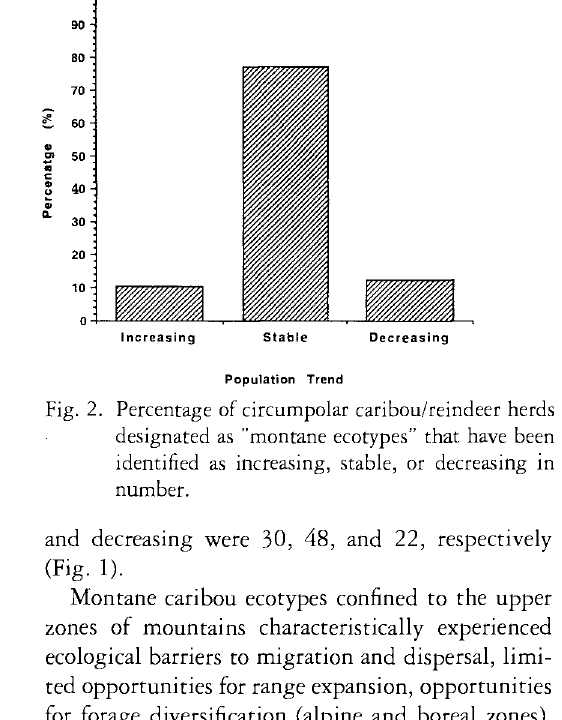
Fig. 2. Percentage of circumpolar caribou/reindeer herds designated as "montane ecotypes" that have been identified as increasing, stable, or decreasing in number.